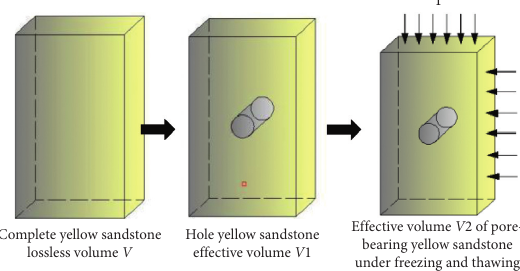
Figure 11: Damage process of yellow sandstone with pores under freezing and